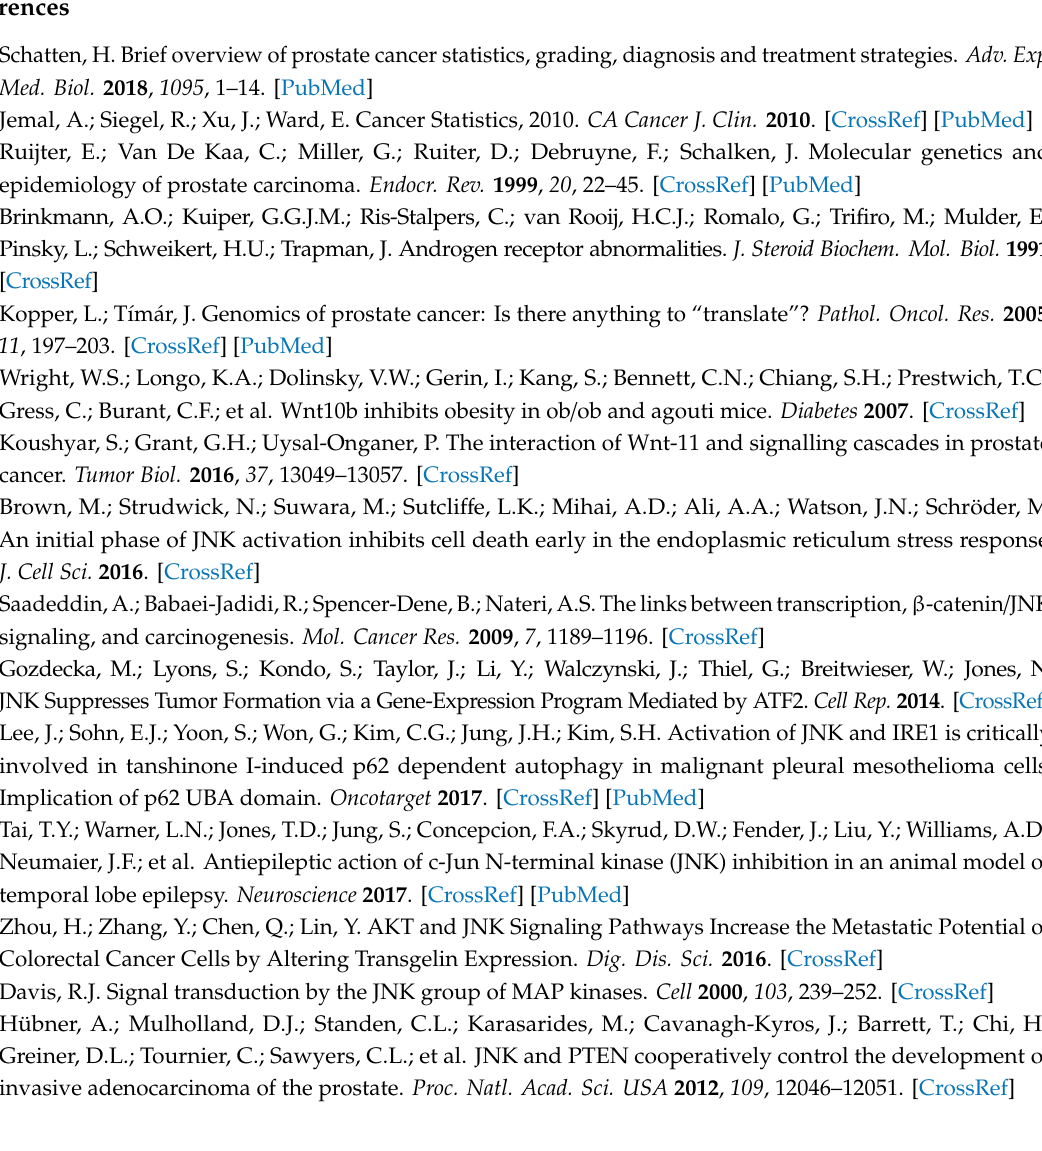
Figure S1. JNK inhibition (10 µ M) resulted in an increased ROS generation and acidic vacuole formation in both DU145 and PC-3 PCa cells. Figure S2. JNK inhibitor decreased 3D spheroid growth and invasive potential of DU145 cells within 96 h. Figure S3. JNK inhibitor (10 µ M) decreased anchorage-independent growth of DU145 and PC3 prostate cancer cells. Figure S4. Real-time qPCR result of Wnt-11 relative mRNA expression in PC3